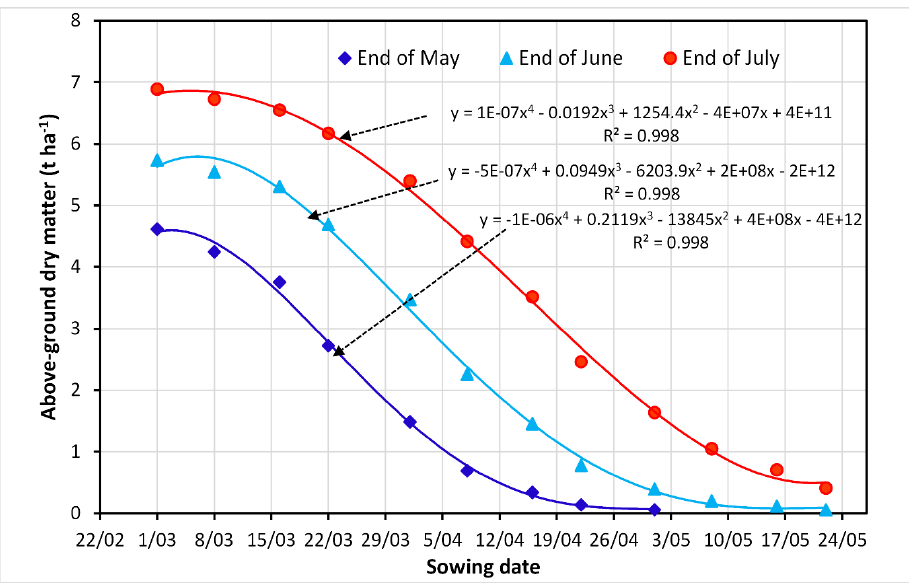
Figure 7. The change in potential above-ground dry matter at the ends of May, June, and July for a dual-purpose wheat sown at different times from the first week of March to the a dual-purpose wheat sown at di ff erent times from the first week of March to the last week of May. last week of May. Simulated using 1950 − 2018 weather data. Simulated using 1950–2018 weather